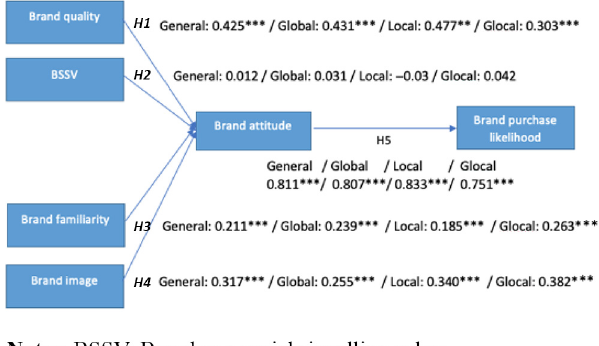
Figure 3. Hypotheses